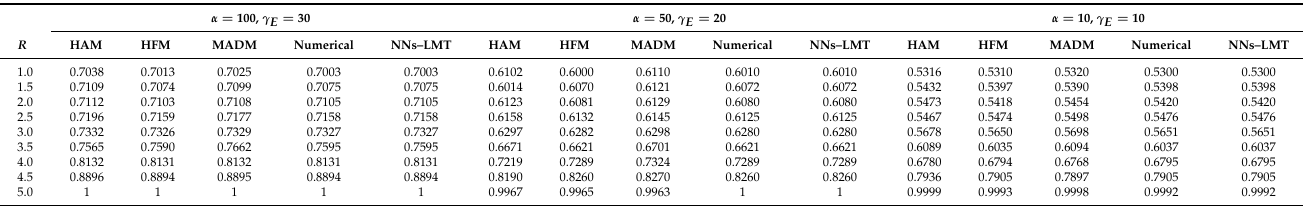
Table 1. Comparison of approximate solutions obtained by NNs–LM algorithm with homotopy analysis method, modified Adomain decomposition method, hyperbolic function method and numerical solver